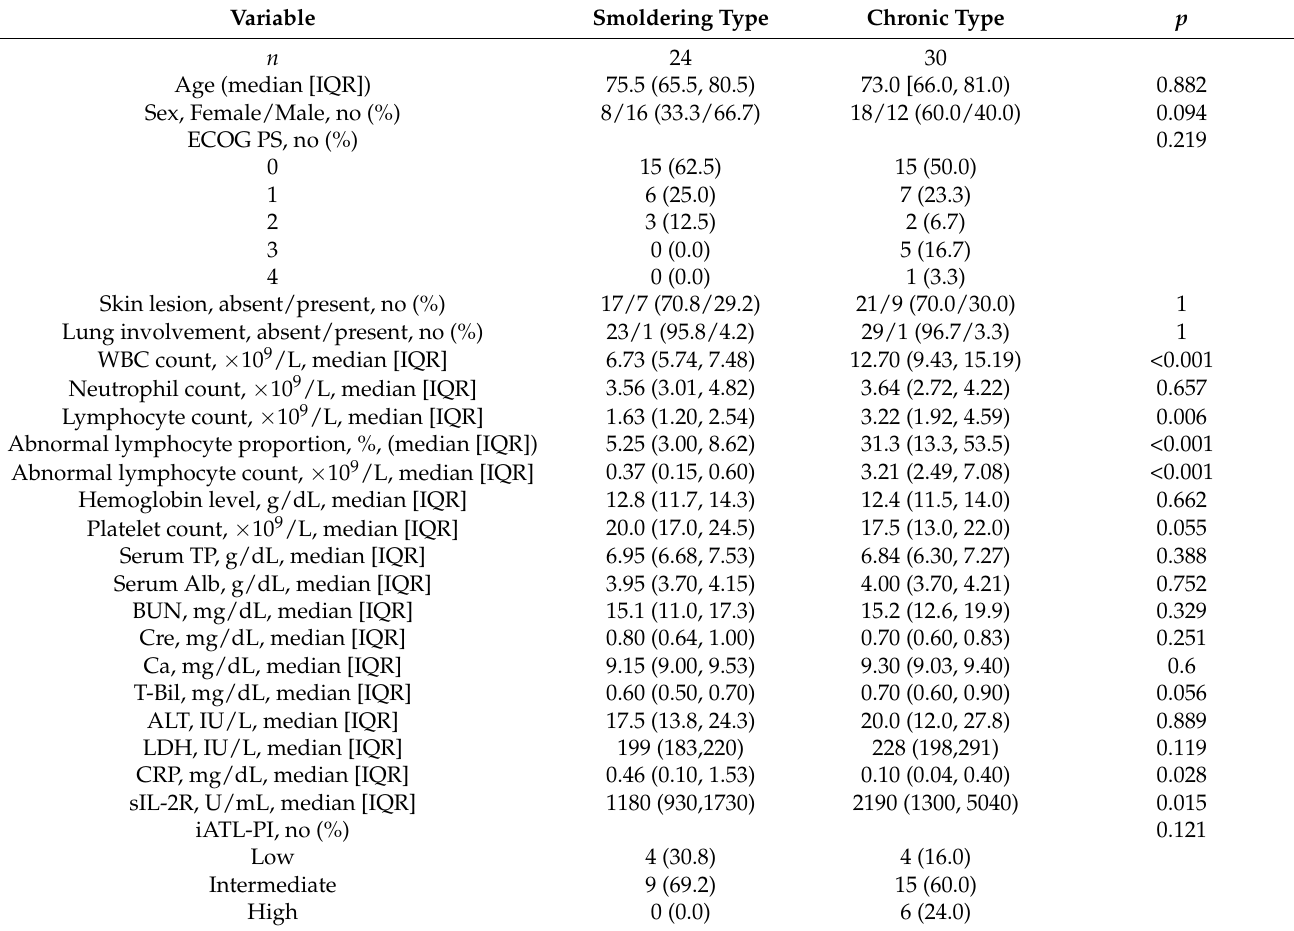
Table 1. Clinical characteristics of all patients ( n =